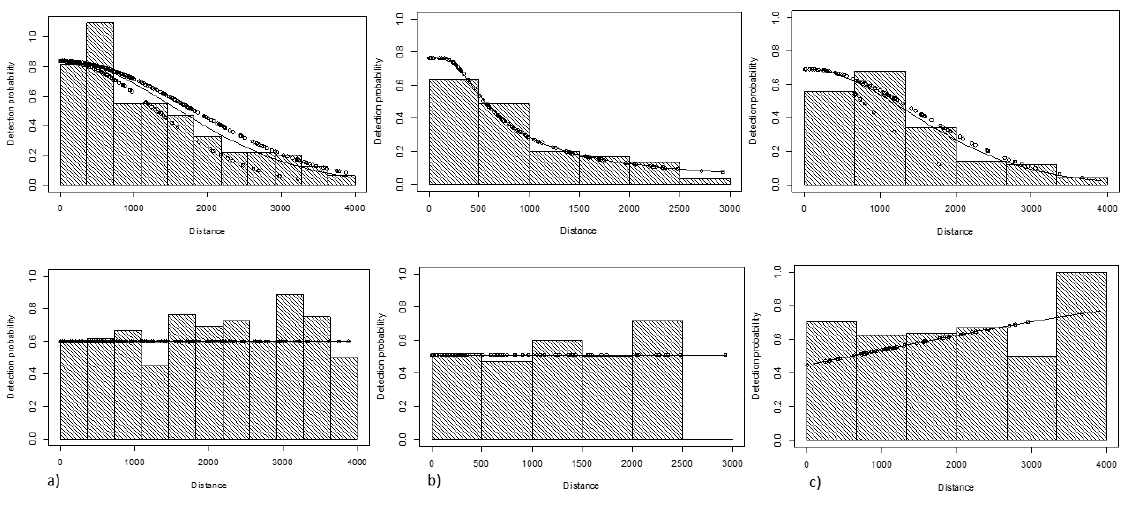
Figure 4. Detection function curves for pooled detections (top) and the conditional detection probabilities of platform 1 (bottom) for (a) fin whales, (b) humpback whales, and (c) sperm